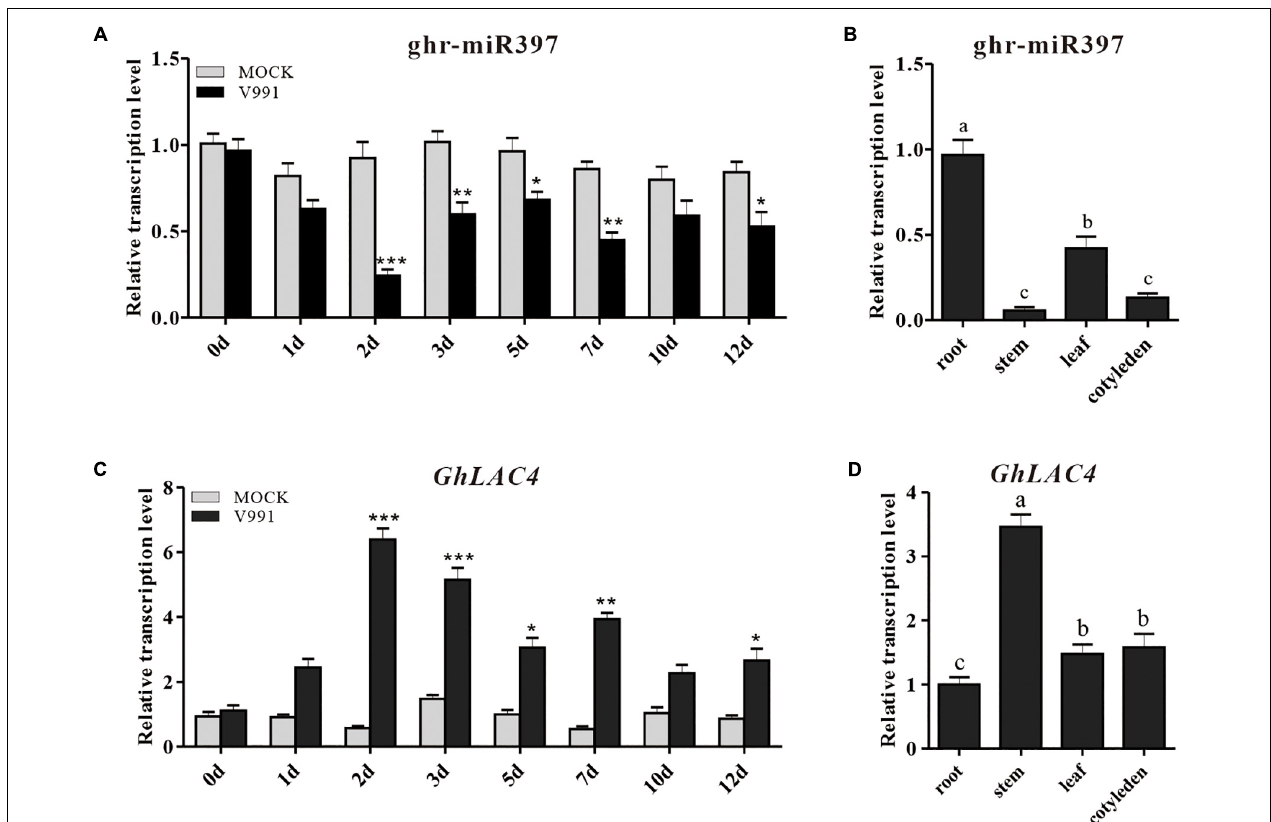
FIGURE 1 | Expression pattern analysis of ghr-miR397 and GhLAC4 . (A) The ghr-miR397 accumulation under Verticillium dahliae infection and mock treatment. (B) The expression profile of ghr-miR397 in various cotton tissues. (C) Expression profile of GhLAC4 in the time course of cotton roots infected with V. dahliae . (D) Expression analysis of GhLAC4 in various cotton tissues. The abundance values of ghr-miR397 and GhLAC4 in cotton roots were arbitrarily assigned as ‘1.’ Mean with SD comes from triple repeats experiments. Significant differences in (A,C) were determined using Student’s t -test ( *P < 0.05, ** P < 0.01, *** P < 0.001). Different letters in (B,D) indicate significant differences ( P < 0.05) based on Tukey’s HSD test.